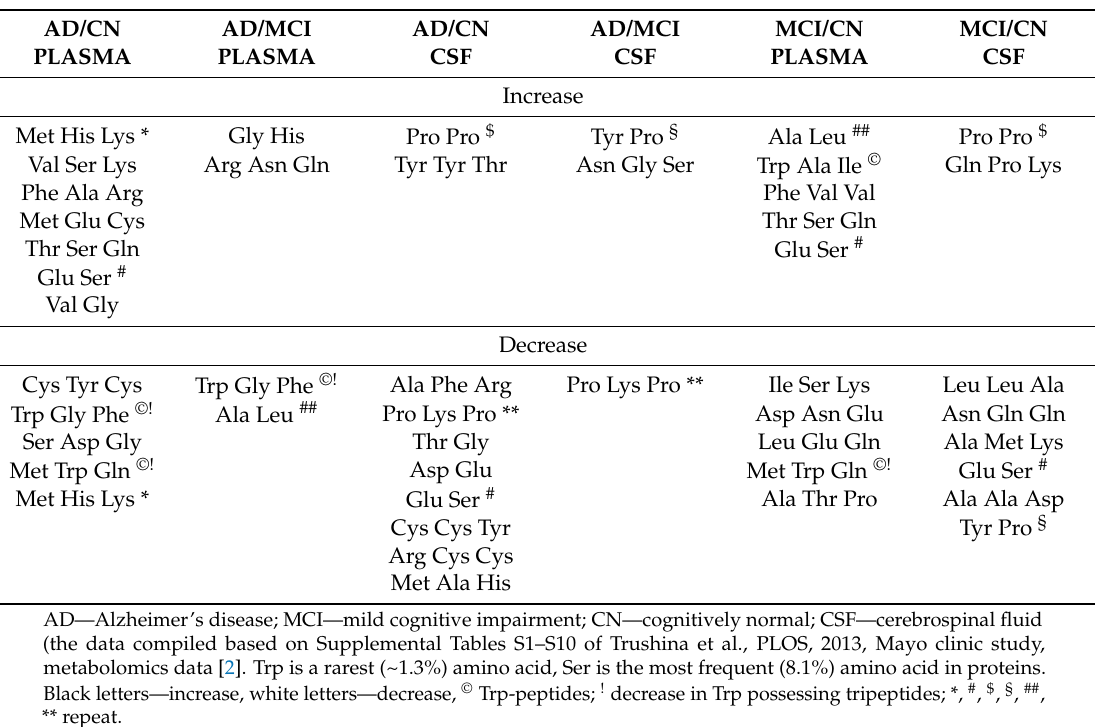
Table 2. The di- and tripeptides altered in plasma and CSF of AD and MCI.